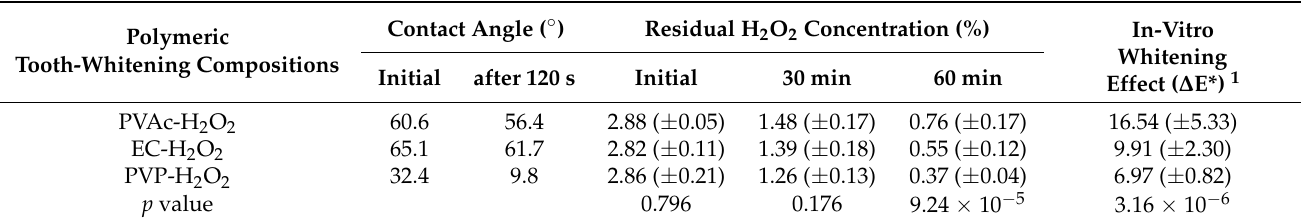
Table 1. Contact angle, residual H 2 O 2 concentration, and whitening effect of polymeric tooth- whitening compositions.